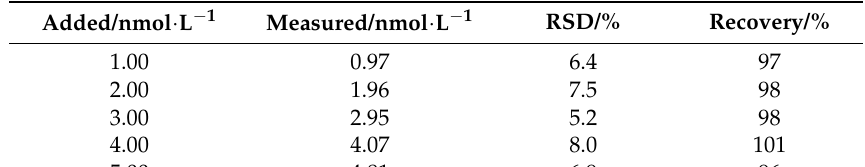
Table 2. Detection of thrombin in the human blood serum substrate ( n = 3) by our method. The sera were 10-fold diluted with Tris-HCl buffer (pH = 7.4).